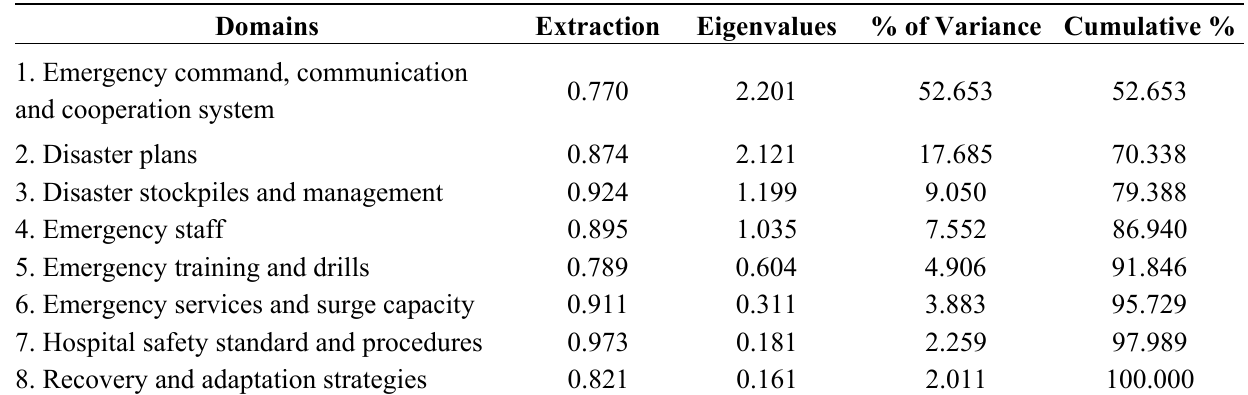
Table 1. Total variance